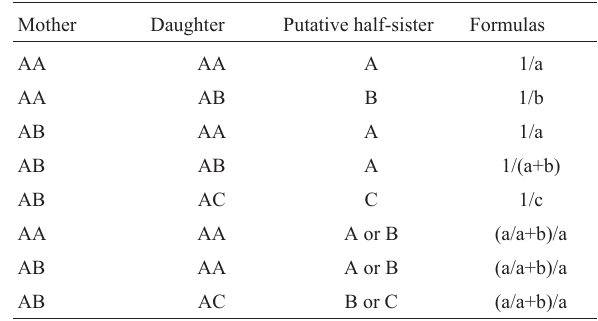
Table 3 - Formulae to calculate PI considering the profile configurations depicted with ChrX STRs, in cases 3 and